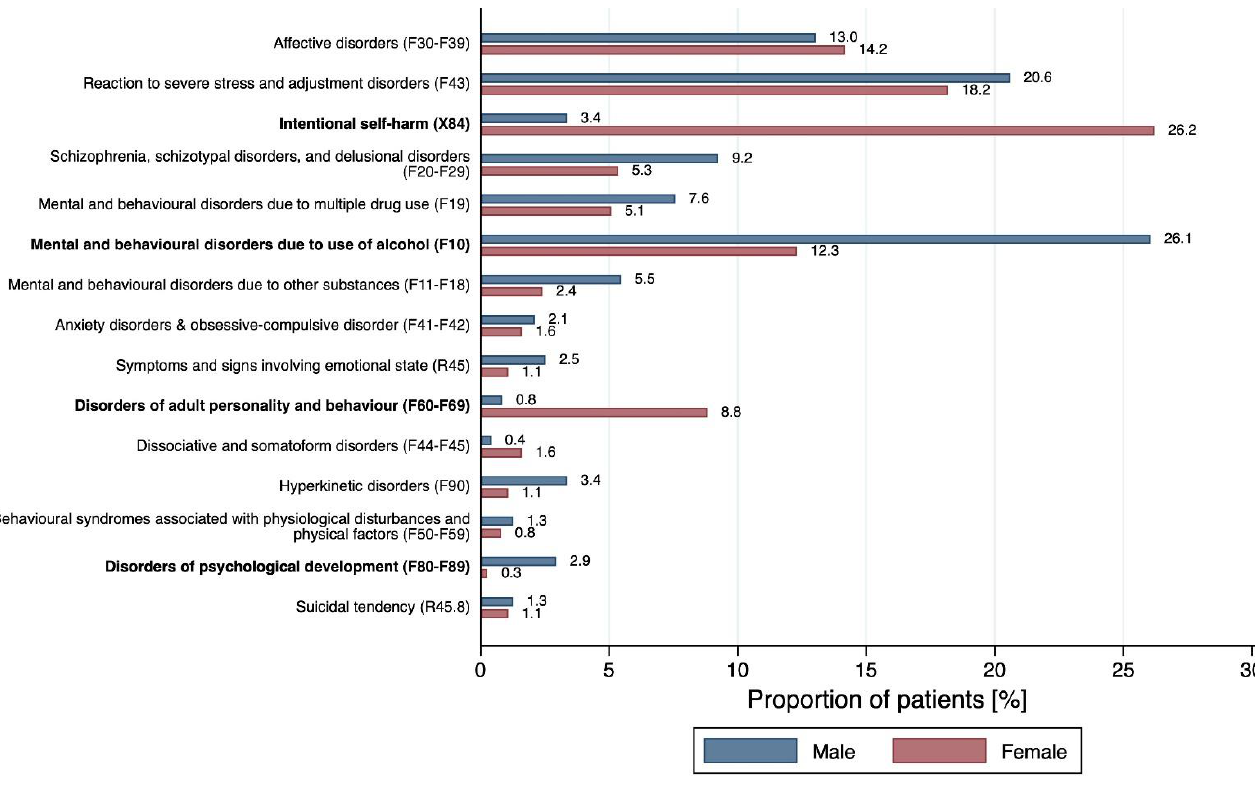
Figure 2. Sex differences of diagnosis groups according to ICD-10. Variables with significant differ- ences between males and females are shown in bold ( p < 0.05). Table 2. Acute suicidal ideation and history of psychiatric